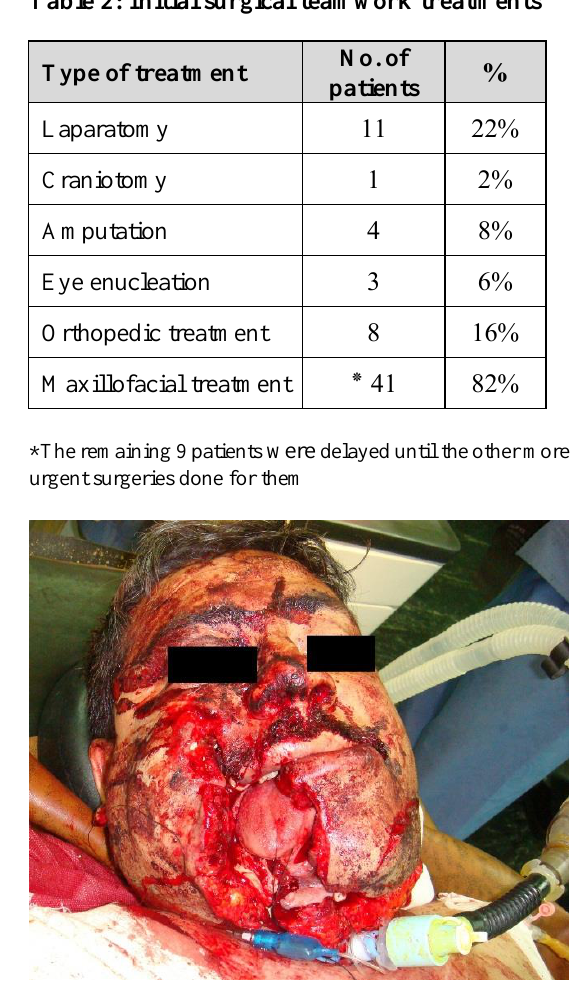
Figure 1: Patient with severe maxillofacial injury, the airway was secured by a